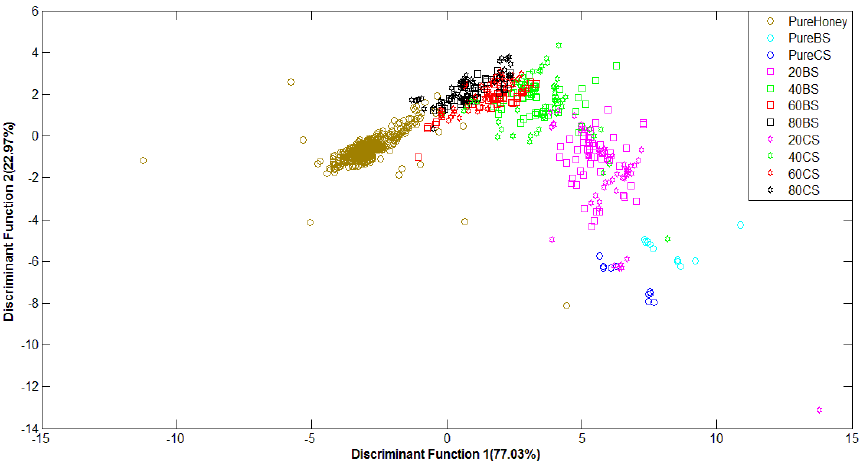
Figure 11. LDA plot of ILF norm data.